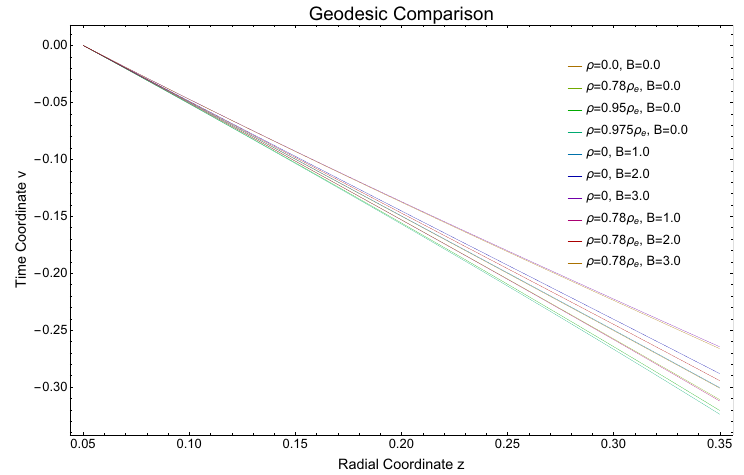
Figure 8 . Comparison of the bulk time v as a function of radial coordinate z for the late time geodesics computed for all cases (a)-(d). All cases are plotted as v ( u ) (cid:0) v (0 : 05). Each case exhibits a di(cid:11)erent angle (cid:18) = arctan ( v=z ) backwards through time into the